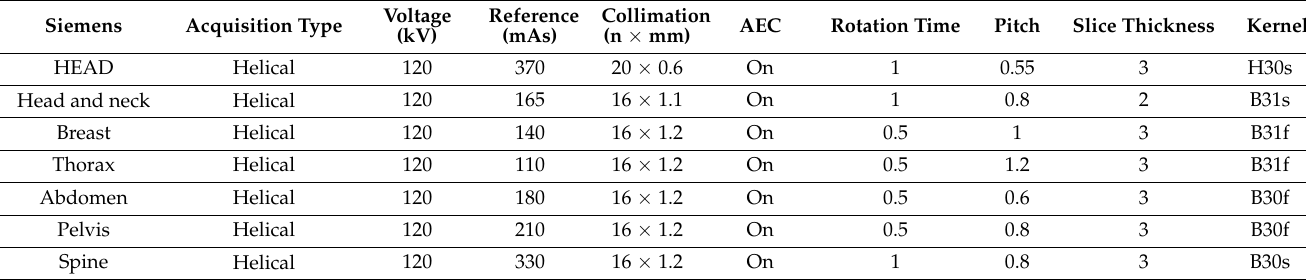
Table 7. Scanning parameters of the simulation protocols in Siemens CT unit.